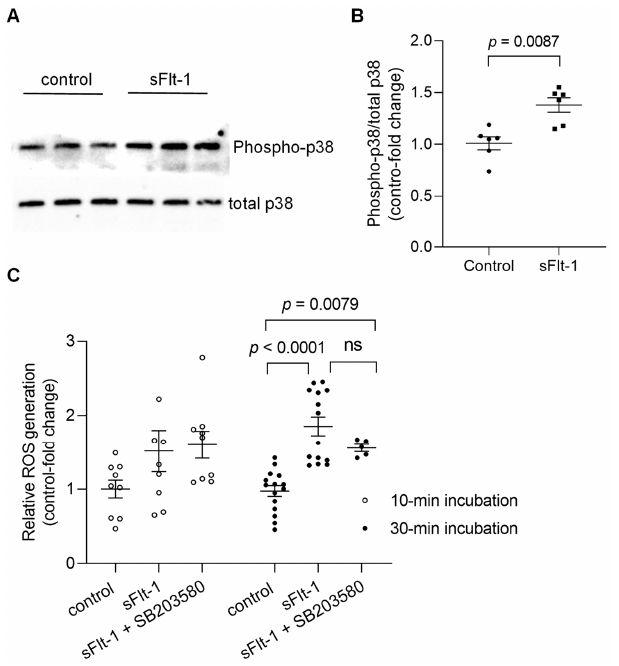
Figure 2. Activation of p38 MAPK and ROS generation upon sFlt-1 treatment. ( A ) Representative Western blotting image of phosphorylated (phospho) and total p38 MAPK 10 min after sFlt-1 treat- ment. ( B ) Relative densitometric analysis based on two independent experiments. ( C ) ROS was de- tected by measuring the fluorescence of CellROX Deep Red, a cell-permeant ROS sensor, in cells treated with sFlt-1 for 10 and ~30 min in the presence or not of SB203580 (10 µM). Data are given as fold-change relative to control and expressed as mean ± SEM. MAPK, mitogen-activated protein kinase; ns, not significant; ROS, reactive oxygen species.